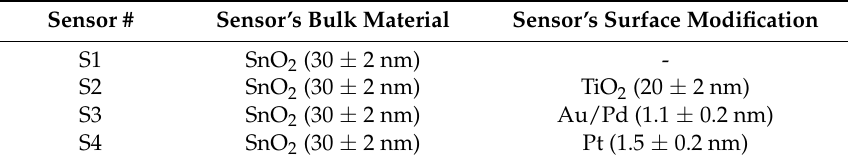
Figure 3. Table-top multisensory gas chromatography (MGC) experimental setup.